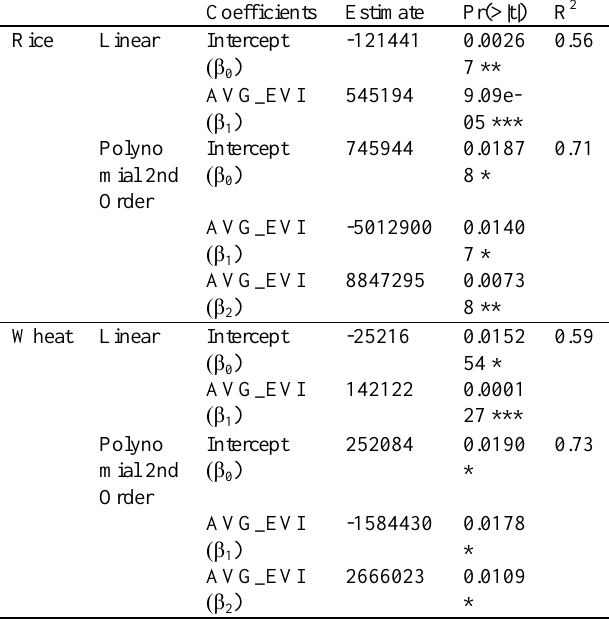
Table 1. Model parameters of Linear and Polynomial